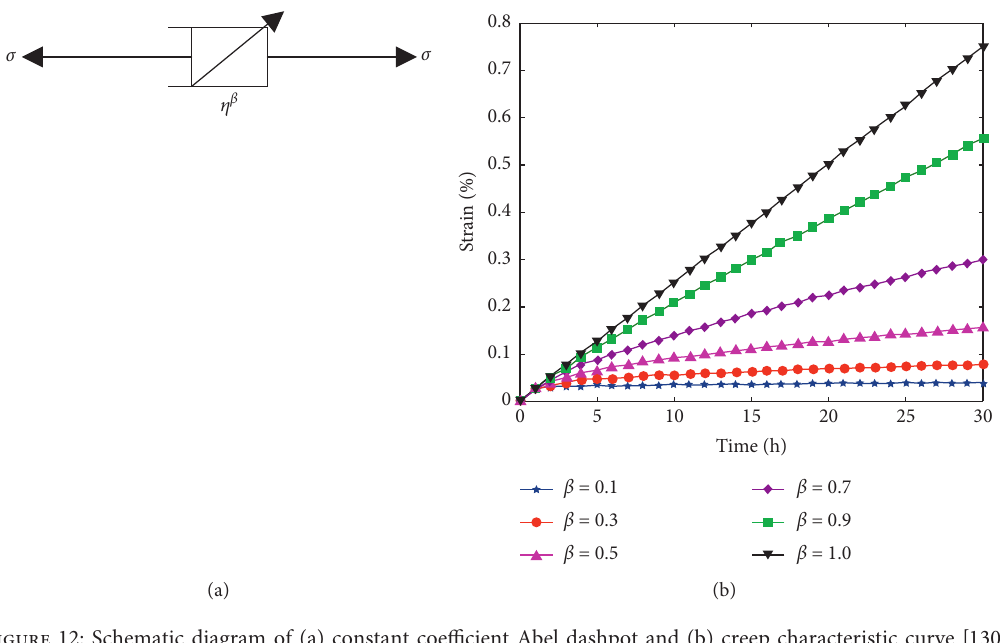
Figure 12: Schematic diagram of (a) constant coefficient Abel dashpot and (b) creep characteristic curve [130]. Eσ